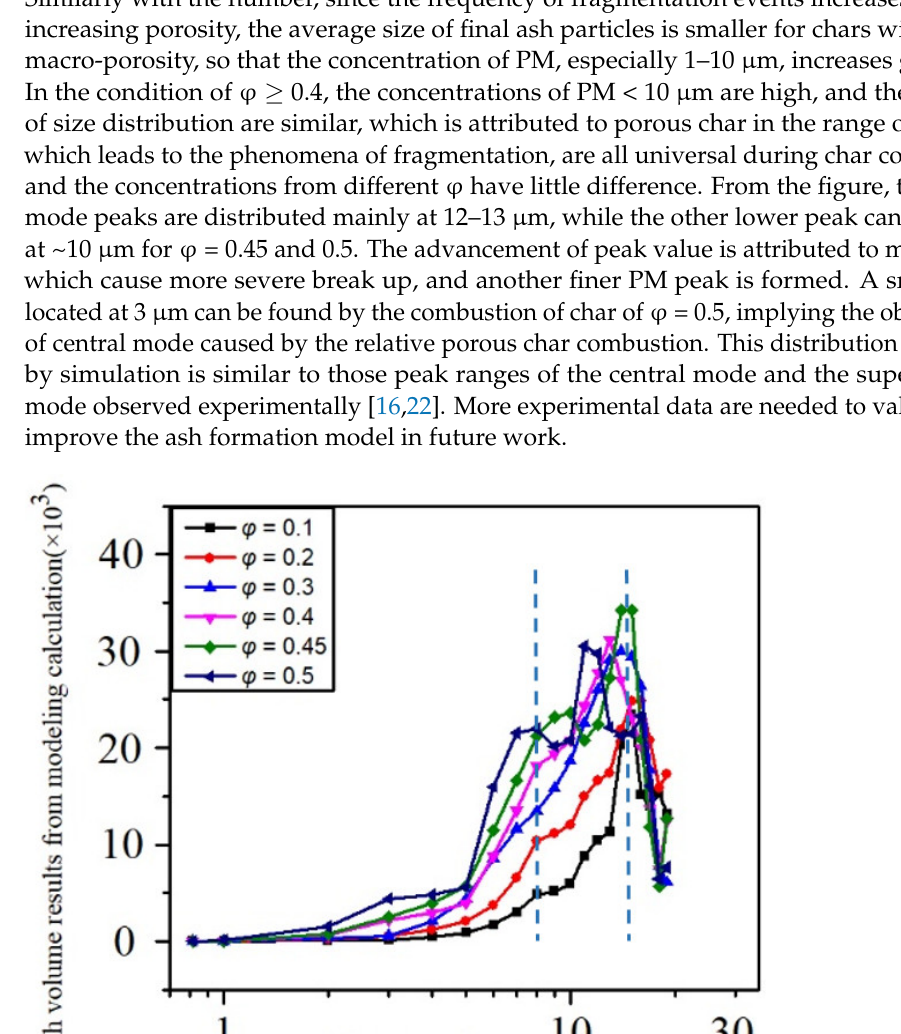
Figure 11. Particle volumetric (concentration) size distribution.